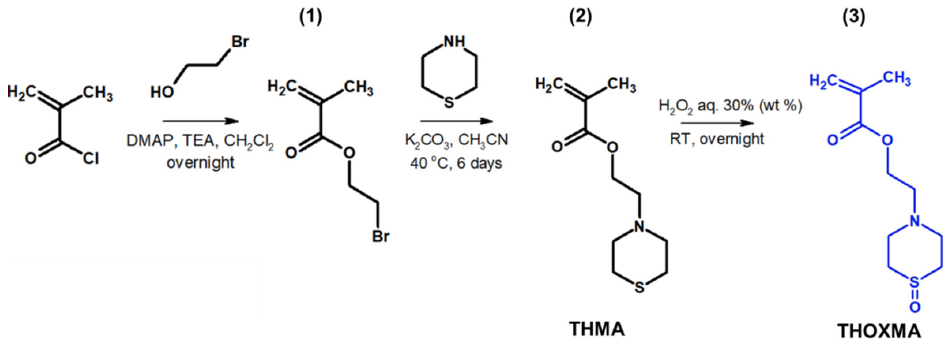
Figure 1. Synthesis of 2-bromoethylmethacrylate intermediary product ( 1 ), the synthesis of ethyl thiomorpholine methacrylate monomer THMA ( 2 ) and its oxidation to ethyl thiomorpholine oxide methacrylate monomer THOXMA ( 3 ).